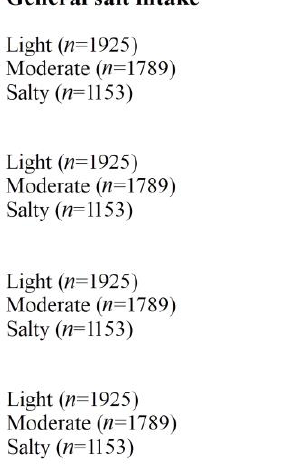
Figure 3. Association of salt intake with falls in the past 6 months on 4867 participants of the Guang- zhou Biobank Cohort Study. OR = odds ratio, CI = confidence interval. † Adjusted OR (95% CI): ad- justed for sex, age, education, family income, occupation, physical activity, smoking status, alcohol use, body mass index (BMI), self-rated health, and self-reported hypertension. No significant interaction was found between general salt intake and sex on grip strength, TUGT score, and falls (Table 2). When stratified by sex, the negative association between general salt intake and RGS remained significant in women, but became non- significant in men. Compared with light salt intake, the RGS in women with high salt intake decreased by 0.04 kg per kg/m 2 . The adjusted β (95% CI) of four indicators of RGS was − 0.04 ( − 0.06, − 0.02) kg per kg/m 2 ( p < 0.05, Table 2). Table 2. Associations of general salt intake with grip strength, timed up-and-go test, and falls in 1351 men and 3516 women of the Guangzhou Biobank Cohort Study. Men